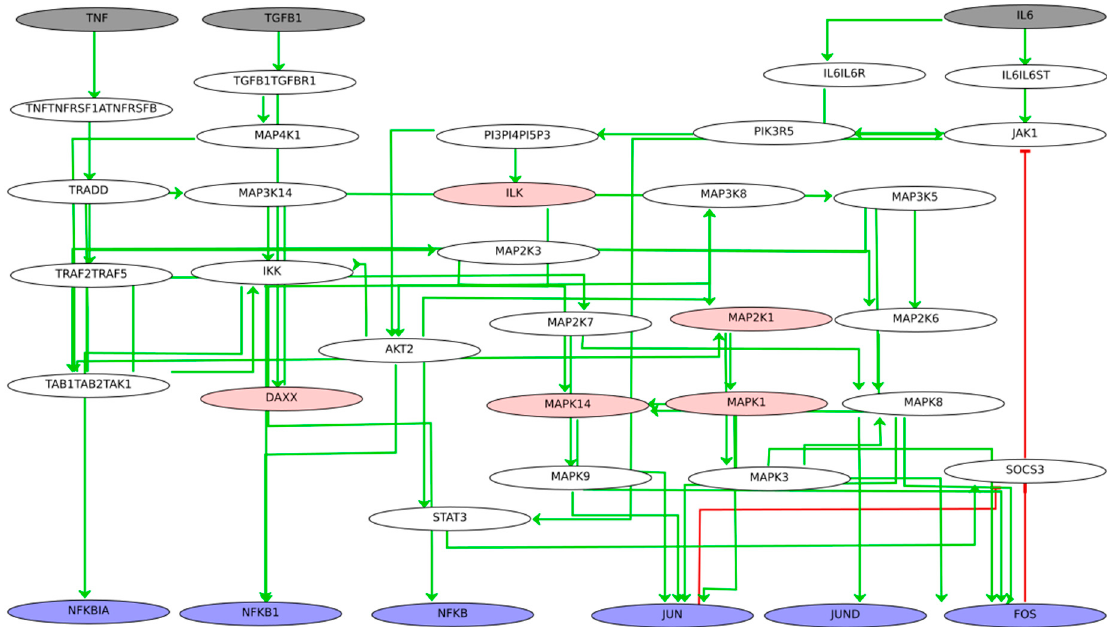
Figure 8. The Boolean network comprising the three signalling cascades for TNF, TGFB1, and IL6. Boolean rules were inferred using the tool CaSQ (see Section 2 for a step-by-step model inference). Inputs are depicted in grey, TFs of interest are depicted in purple, and intermediate nodes affected by the drug treatment or identified as mutation carriers are depicted in pink. Green arrows denote activation, and blunt red arrows denote inhibition. Table 4. Stable states of the Boolean network (wild type).